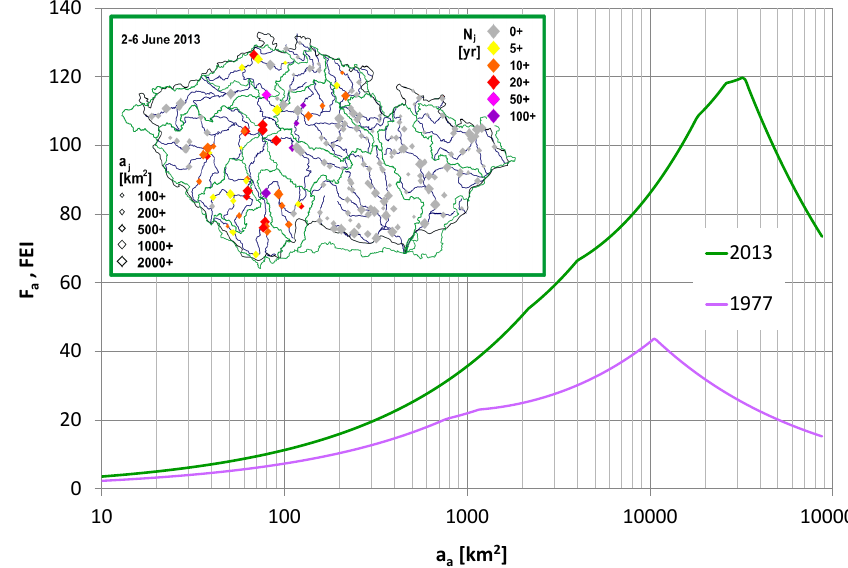
Figure 5. Evaluation of extremity of floods in May–June 2013 and in August 1977 using the FEI. The step-by-step aggregated catchments are ordered in descending order with respect to return periods recorded there. The inset map presents return periods N j of peak discharges at gauges in 2013; blue and green curves correspond to the main rivers and watersheds,